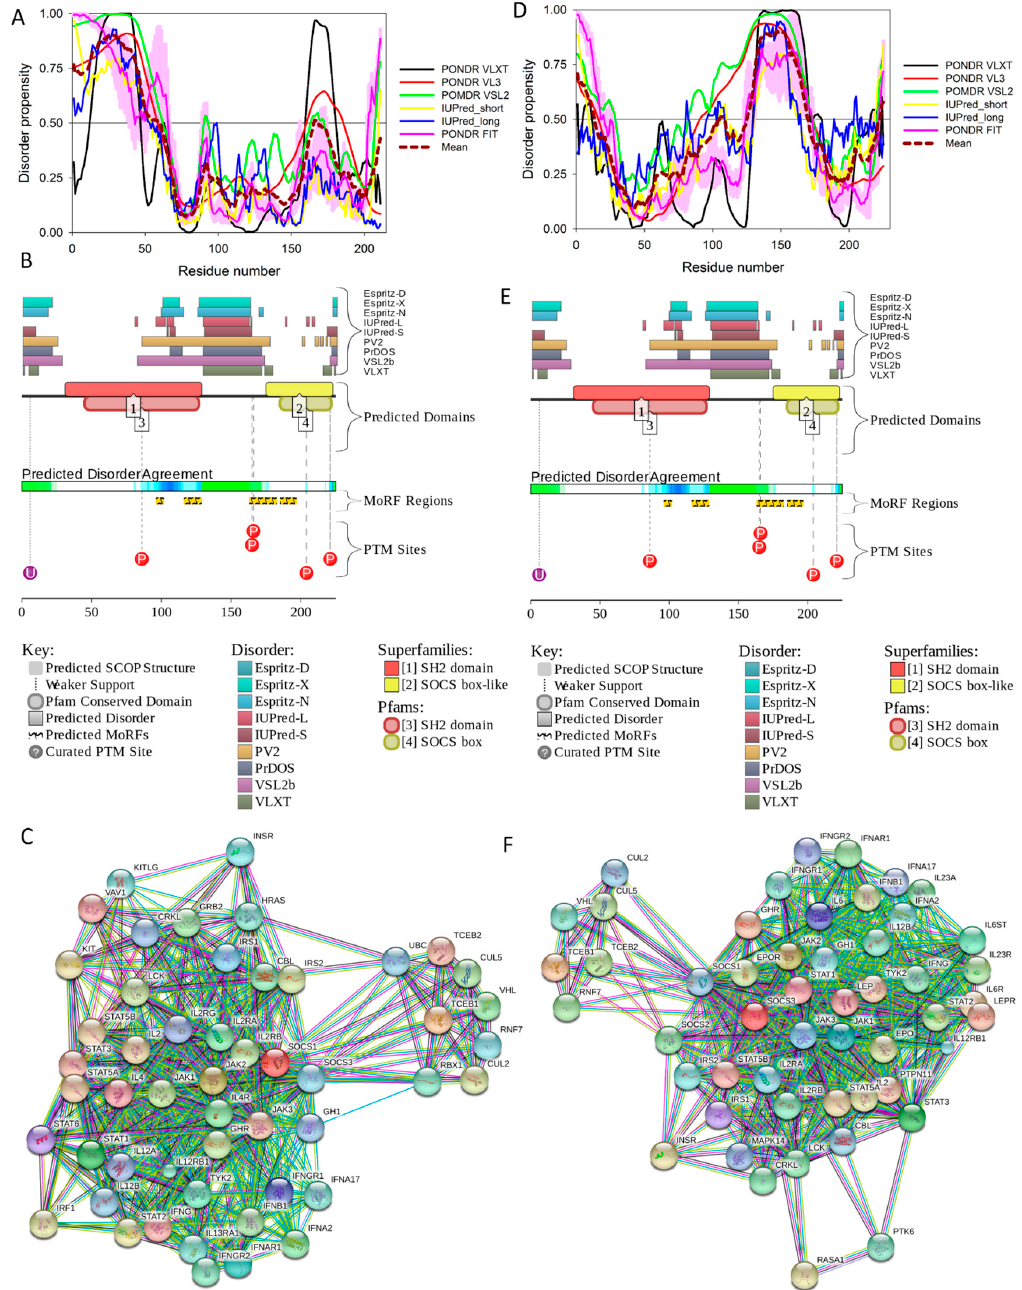
Figure 16. Multiparametric analysis of functional intrinsic disorder and interactability of human SoCS1 (UniProt ID: O15524, ( A – C )) and SoCS3 (UniProt ID: O14543, ( D – F )) proteins. ( A , D ) Evaluating intrinsic disorder propensity by per-residue disorder predictors, PONDR ® VLXT, PONDR®VSL2, PONDR ® VL3, IUPred_short, IUPred_long, and PONDR ® FIT. Plots ( B , E ) Analysis of the intrinsic disorder propensity and some important disorder-related functional information generated by the D 2 P 2 database (available online: http://d2p2.pro/). ( C , F ) STRING-based analysis of the interactivity of human SoCS1 and SoCS3 proteins.